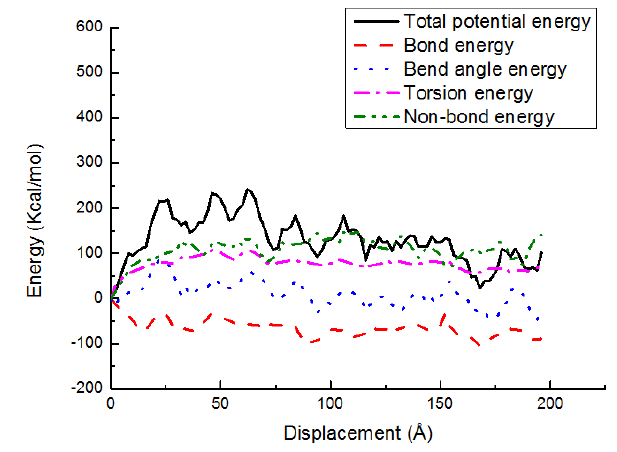
Figure 16. Potential energy-displacement curves for the PE(150 – 20)/S interface in the shear case.